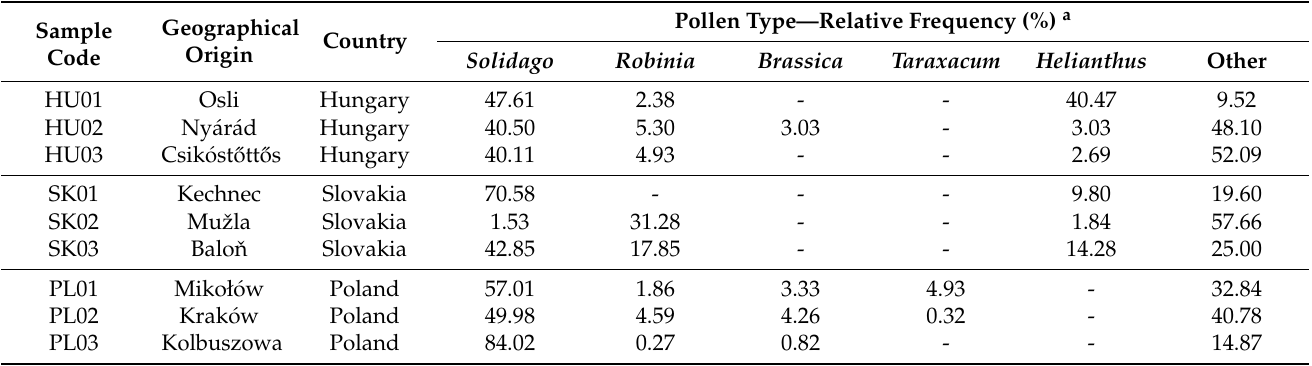
Table 1. Pollen analysis of Hungarian-, Slovak-, and Polish-origin goldenrod